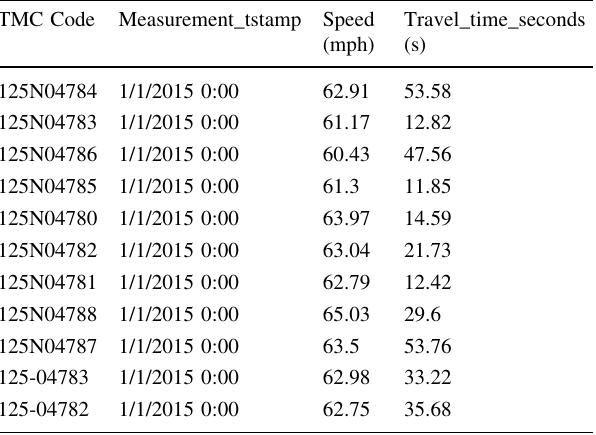
figure, the horizontal axis denotes the time of day and the vertical axis represents TMC segments along the selected section on I-77 southbound. Each cell represents the PTI value. The darker the color, the higher the PTI.